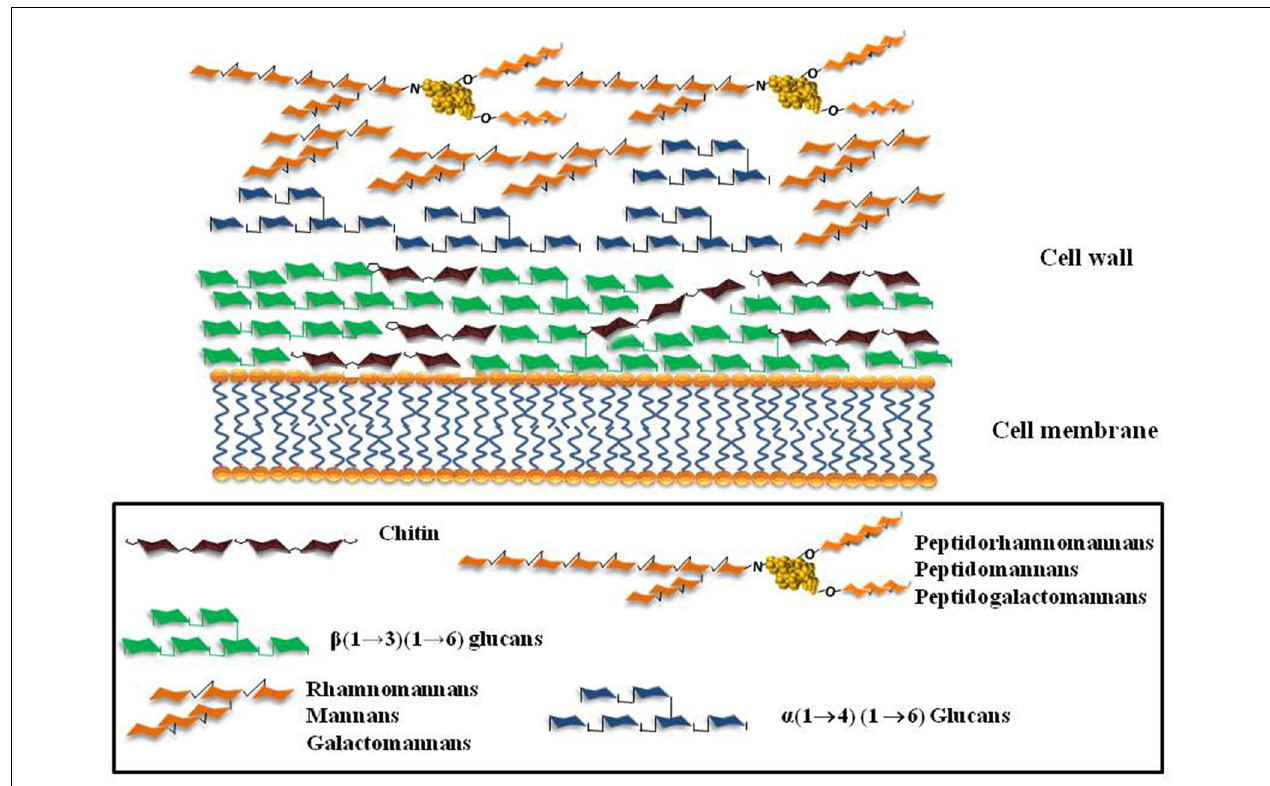
FIGURE 1 | Schematic representation of the major cell wall components of the fungi A. fumigatus , C. albicans , Scedosporium/Pseudallescheria complex.